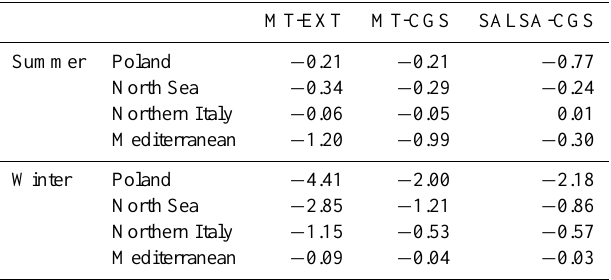
Table 5. The aerosol forcing at the top of the atmosphere (TOA), (cid:49)F net,TOA (Wm − 2 ), for the four different geographical locations, one summer (22 June 2007, 12:00) and one winter (22 Decem- ber 2007, 12:00) event, and three model versions, MT-EXT, MT- CGS, and SALSA-CGS.